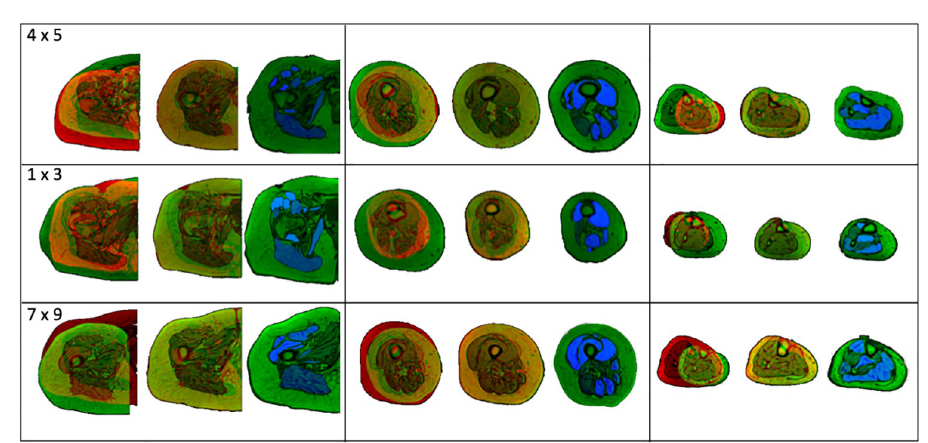
Fig 6. Exemplar augmented images. Inputs, outputs and resulting augmented subjects. Each row of images presents results within the hip (left), thigh (centre), and shank (right) for 3 subject combinations chosen at random (target x reference: 4 x 5 (top), 1 x 3 (middle), 7 x 9 (bottom)). Within each cell there are the inputted images into the registration (left), registered images with corresponding target image (centre) and resulting segmented, augmented images (right). The muscle labels are visible within the augmented images as the blue areas. Each muscle is assigned a distinct greyscale value and the labels are assigned alphabetically. subject (green) is retained, but the cross-sectional area of the thigh is equated to the fixed sub- ject (red). The misalignment of the muscle tissue within the registered images, visible as con- centrations of either red or green colouration, establish a difference in the muscle geometry within the registered and original data. The augmented subjects generated for 1 target subject (subject 1) are presented within S3 File, for visual comparison.